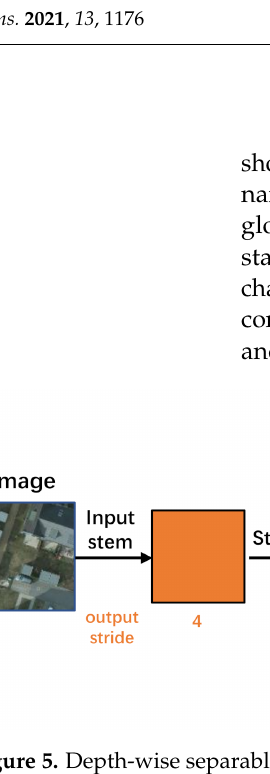
Figure 5. Depth-wise separable atrous spatial pyramid pooling (ASPP) module applied in our model and its rate